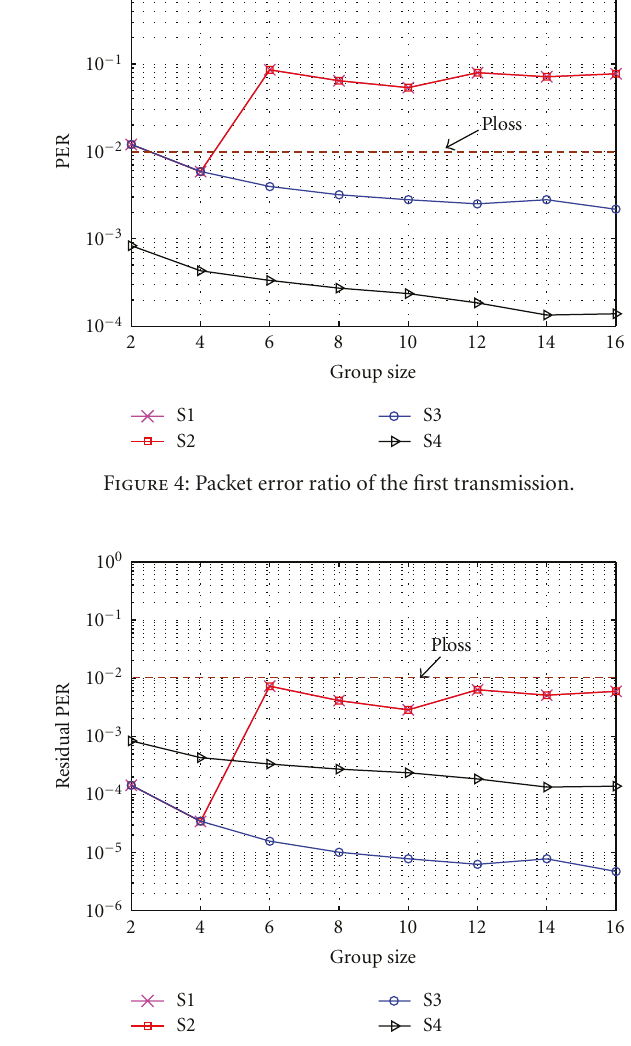
Figure 5: Residual packet error